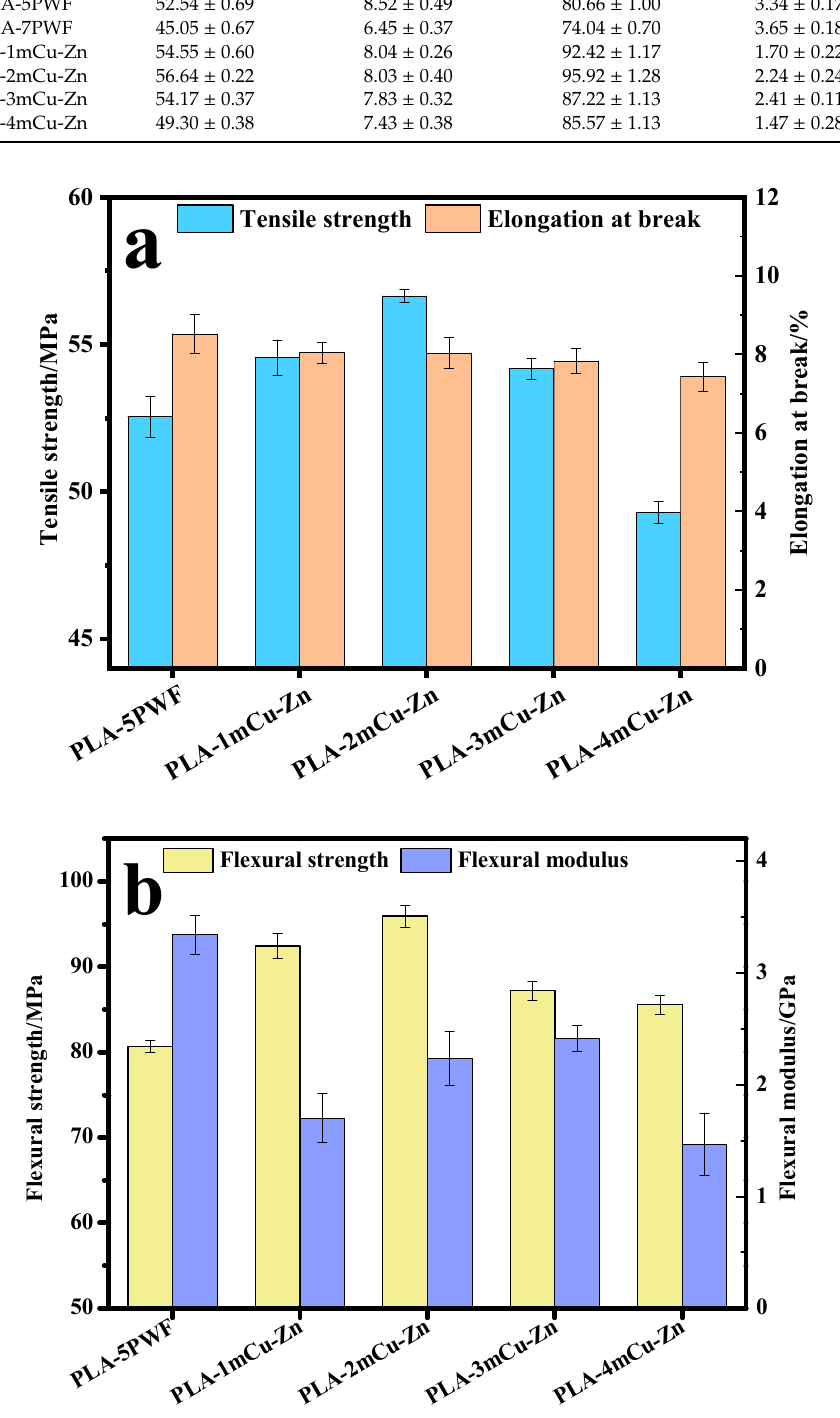
Figure 6. Tensile properties ( a ) and flexural properties ( b ) of mCu-Zn / PWF / PLA composites samples with 5 wt.% PWF.